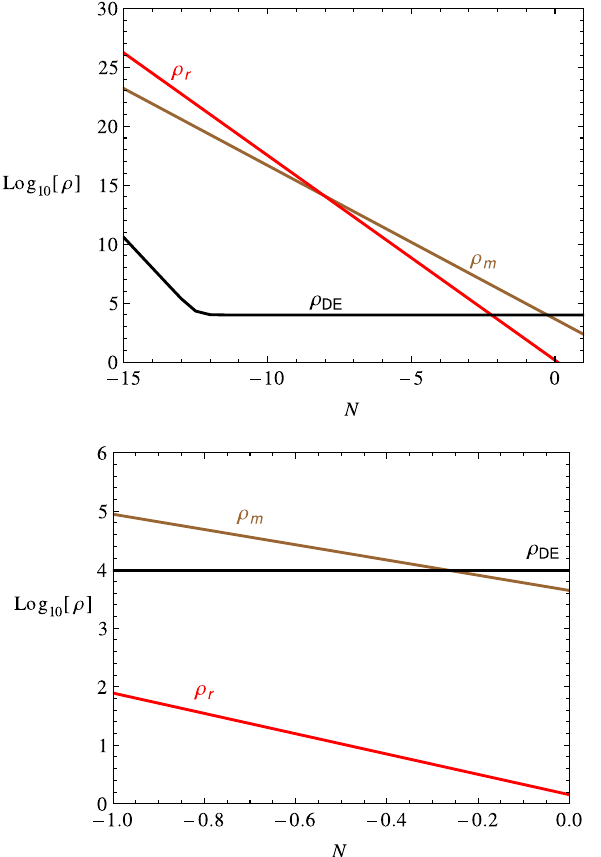
Fig. 4 Plot of the density in the Universe with number of e-foldings N given by N = − ln ( 1 + z ) where z is the corresponding redshift